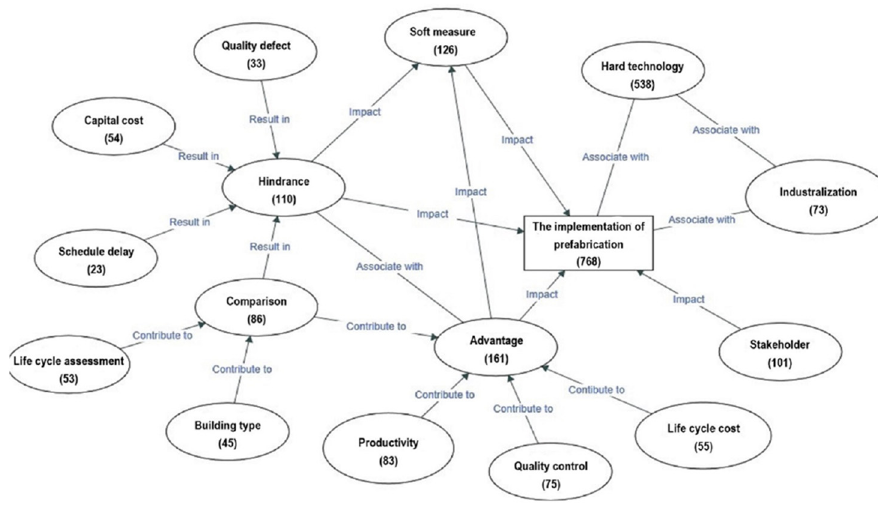
Figure 1. A tentative framework.